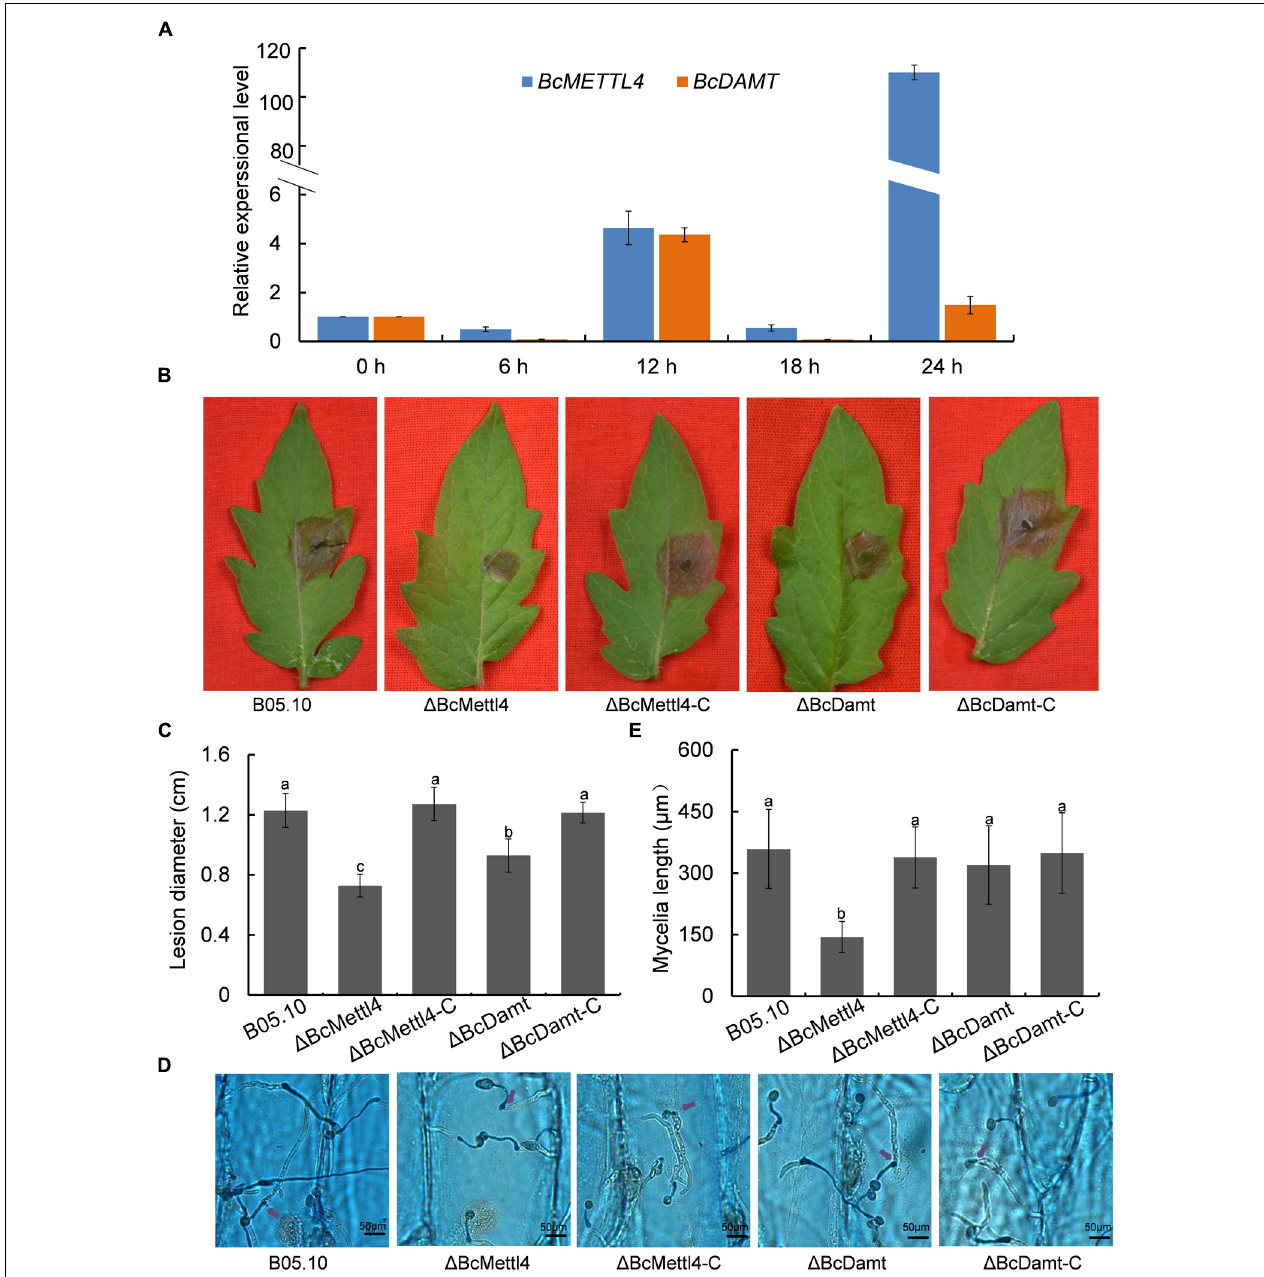
FIGURE 3 | Effects of BcMETTL4 and BcDAMT disruption on virulence and conidia infection. (A) The expression levels of BcMETTL4 and BcDAMT at early infection stages evaluated by qRT-PCR. (B) Lesions on tomato leaves caused by different strains 72 h after inoculation. (C) Lesion diameter of the strains inoculated on tomato leaves. Three experiments were carried out and nine leaves were measured in one biological experiment. Statistical tests were carried out using Tukey’s test. The same letters marked on the bars indicate no significant difference in values at p < 0.05. (D) Infection of conidia from different strains after 12 h of incubation on onion epidermis. Mycelia growing outside onion cells were colored blue, while mycelia growing inside onion cells are not stained. Penetrated positions are marked by purple arrows. (E) Mycelia length of different strains at 12 h after conidia infection on onion epidermis. Data are given as the mean ± SD, n = 10. The different letters showed on the columns were significantly different at p <